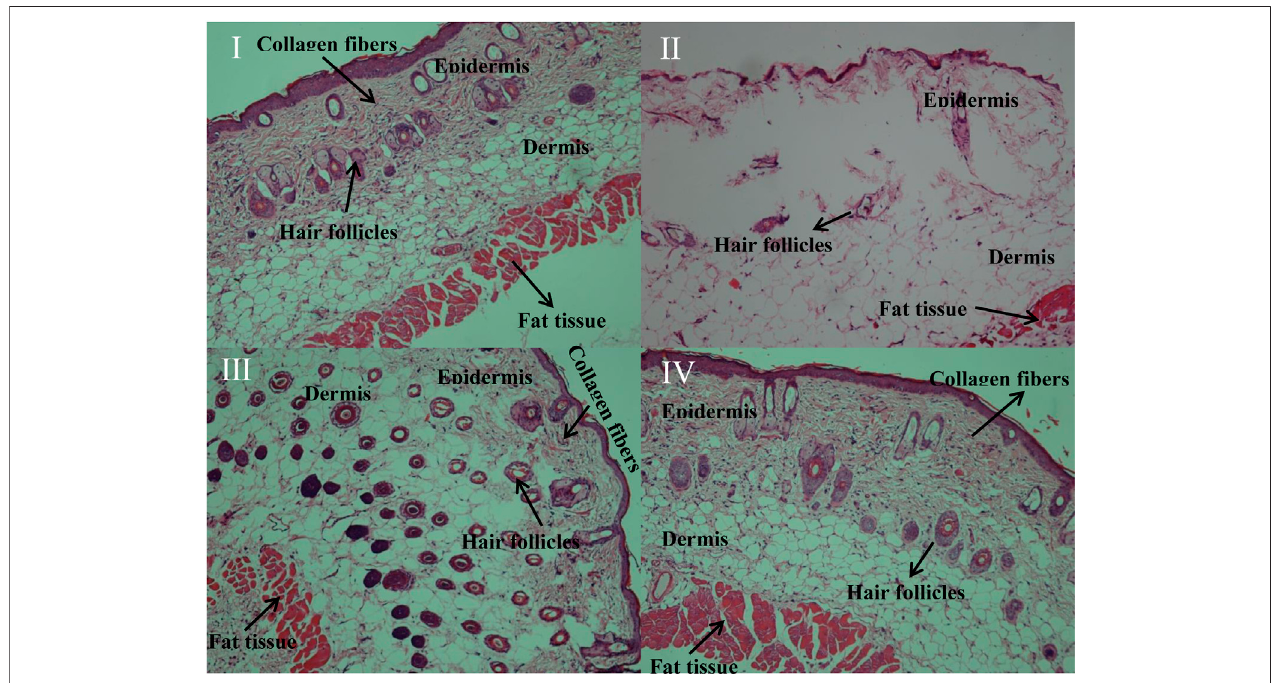
FIGURE 4 | H&E staining of the mouse